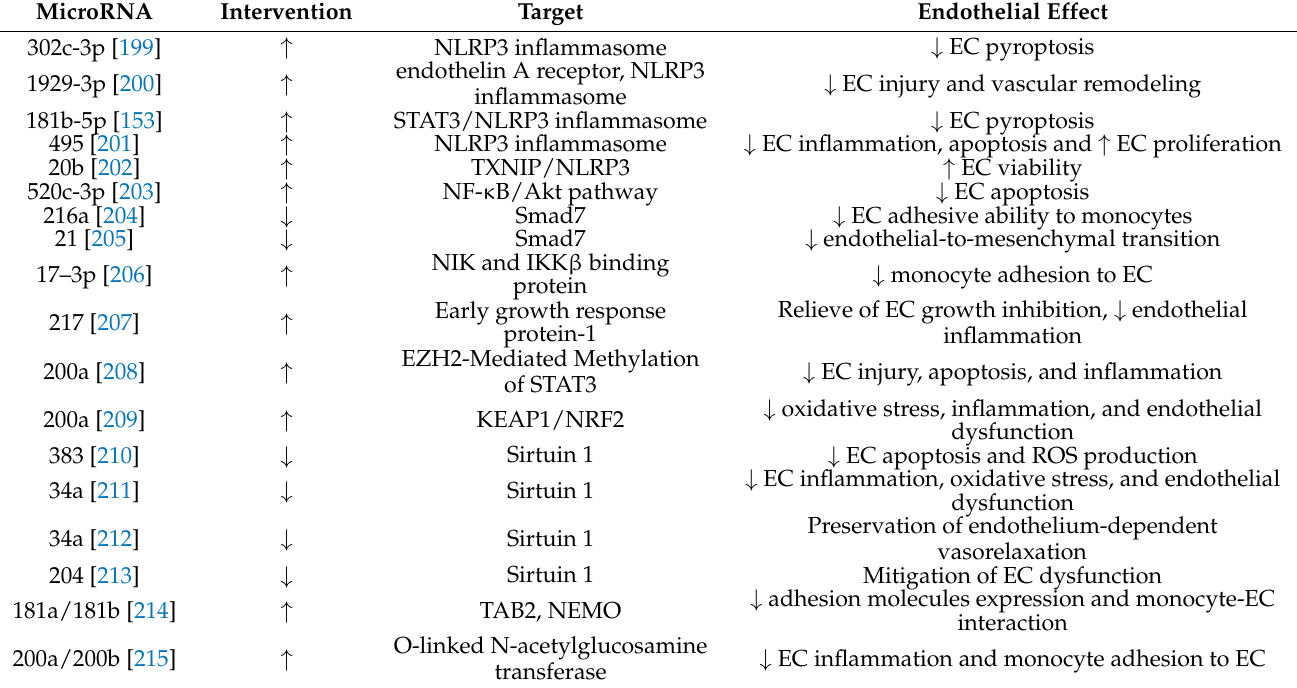
NLRP3: NLR family pyrin domain containing 3, EC: endothelial cell, STAT3: signal transducer and activator of transcription 3, TXNIP: thioredoxin interacting protein, NF- κ B: nuclear factor kappa-light-chain-enhancer of activated B cells, Akt: protein kinase B, Smad7: SMAD family member 7, I κ B α : inhibitor of kappa B α , EZH2: enhancer of zeste homolog 2, KEAP1:Kelch-like ECH-associated protein 1, NRF2: nuclear factor erythroid 2-related factor 2, ROS: reactive oxygen species, NEMO: NF-kB essential modulator. ↑ indicates agonism, ↓ indicates